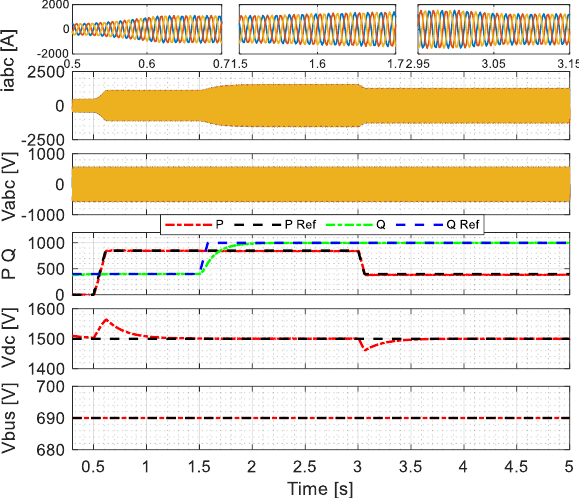
Figure 8. Real and reactive power supply results.